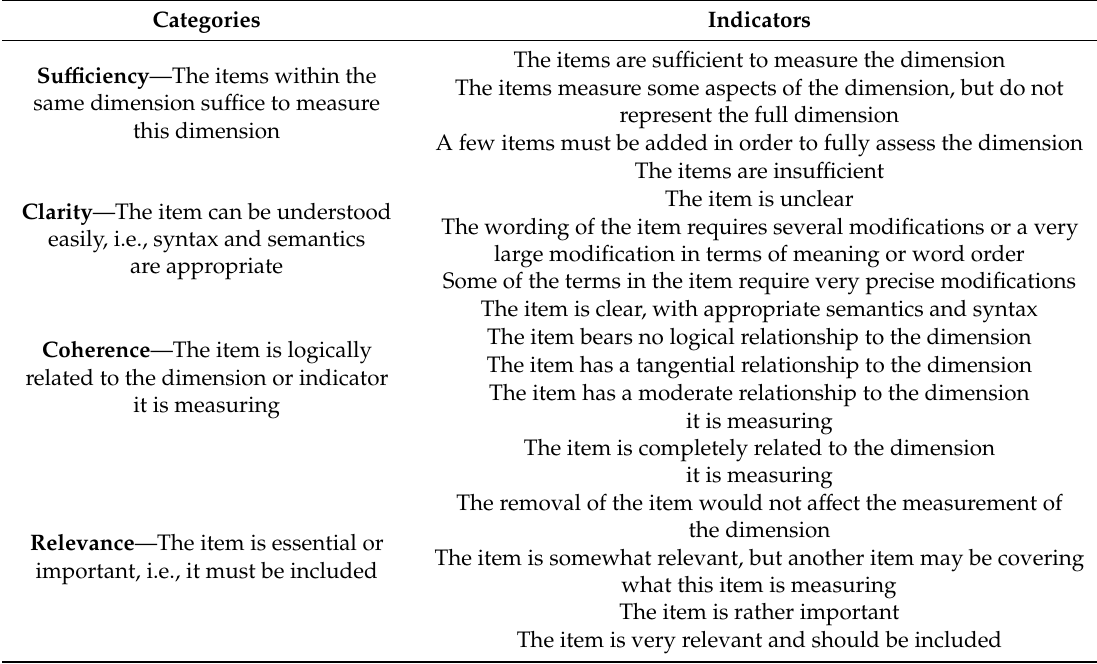
Table 2. Categories and indicators used by the judges to validate the